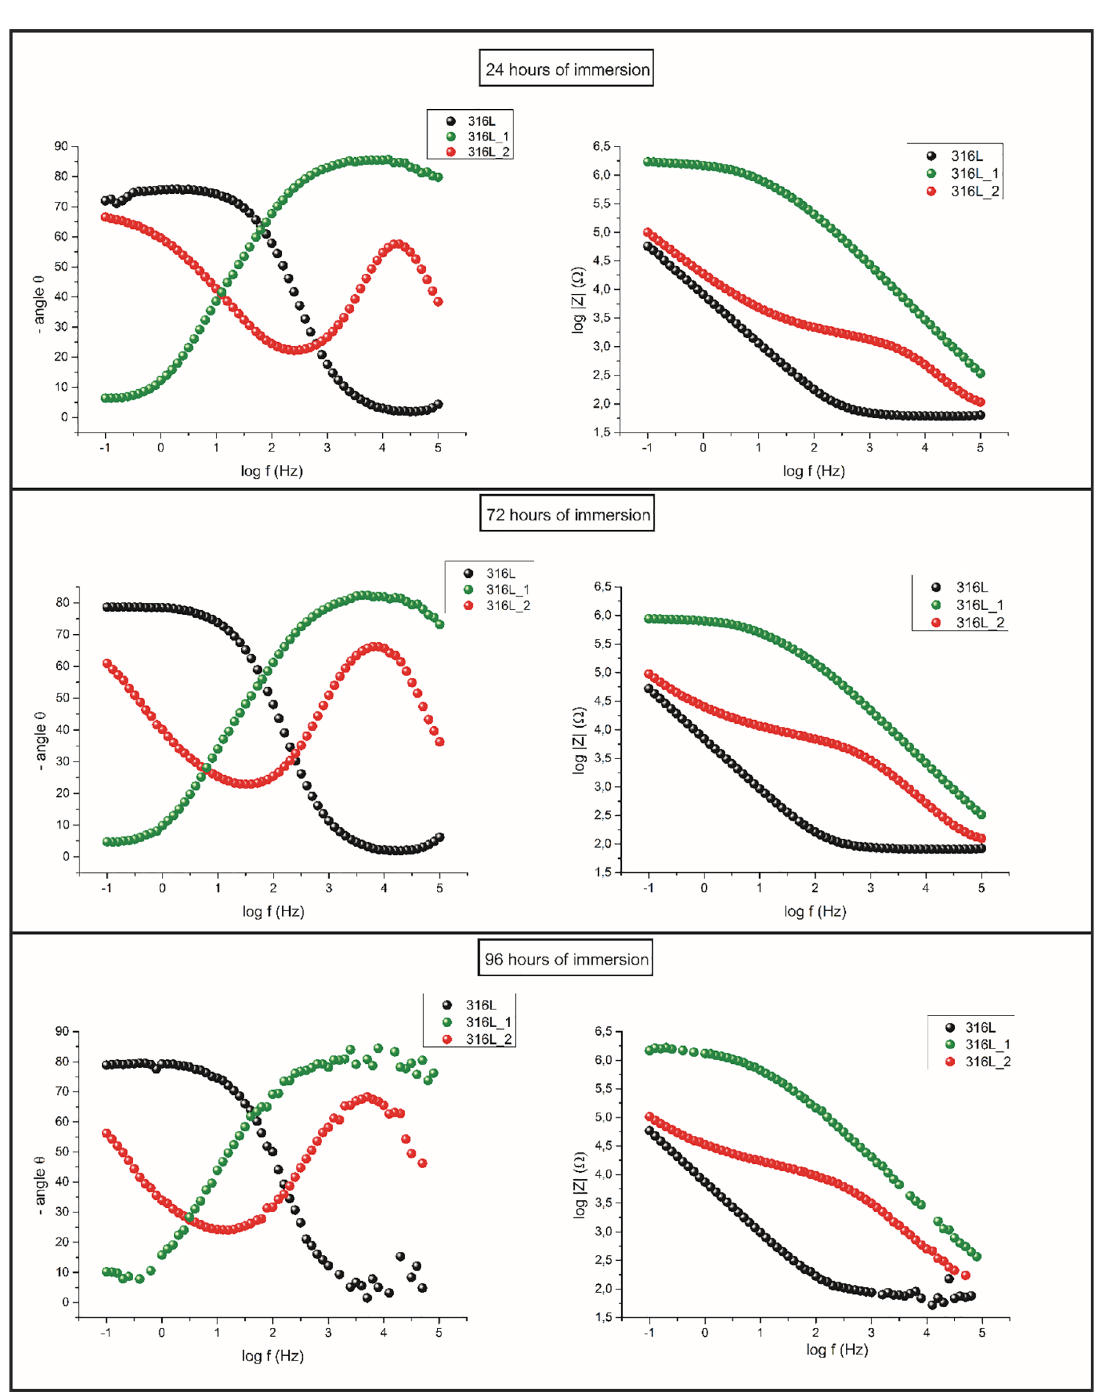
Figure 7. Bode curves of the samples immersed for 24, 72 and 120 hours.